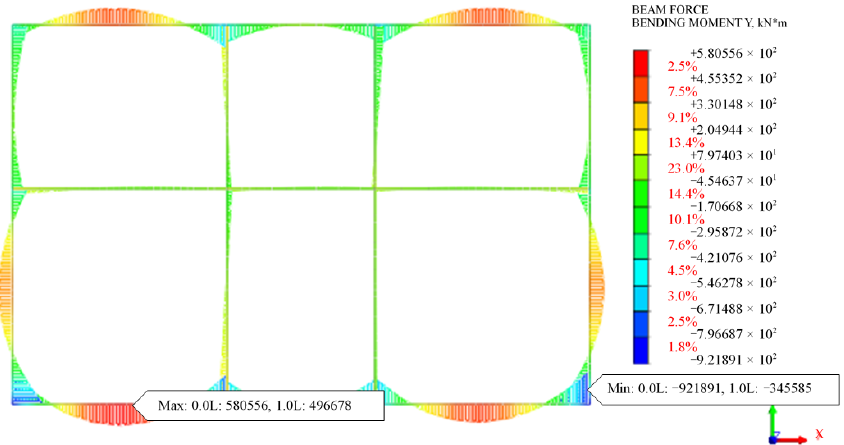
Figure 20. Internal force diagram of typical section structure after